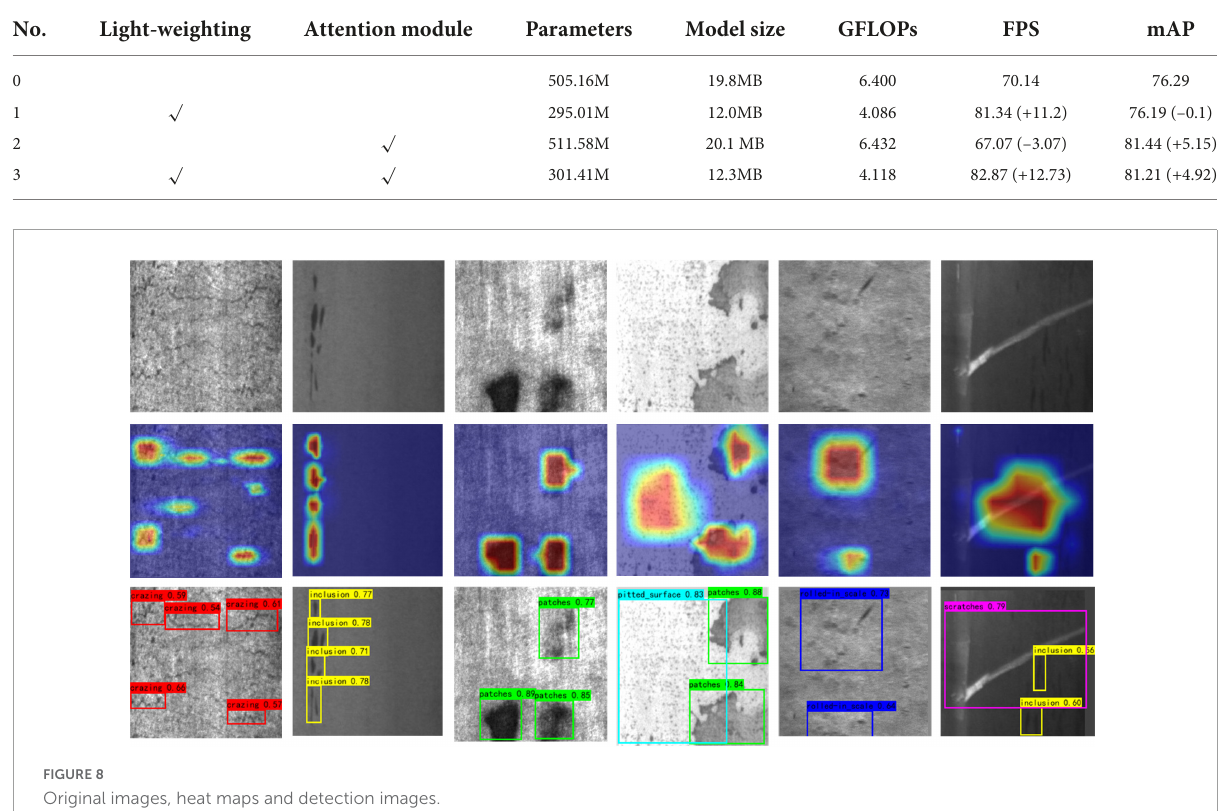
TABLE 1 Ablation study results for enhanced YOLOX.